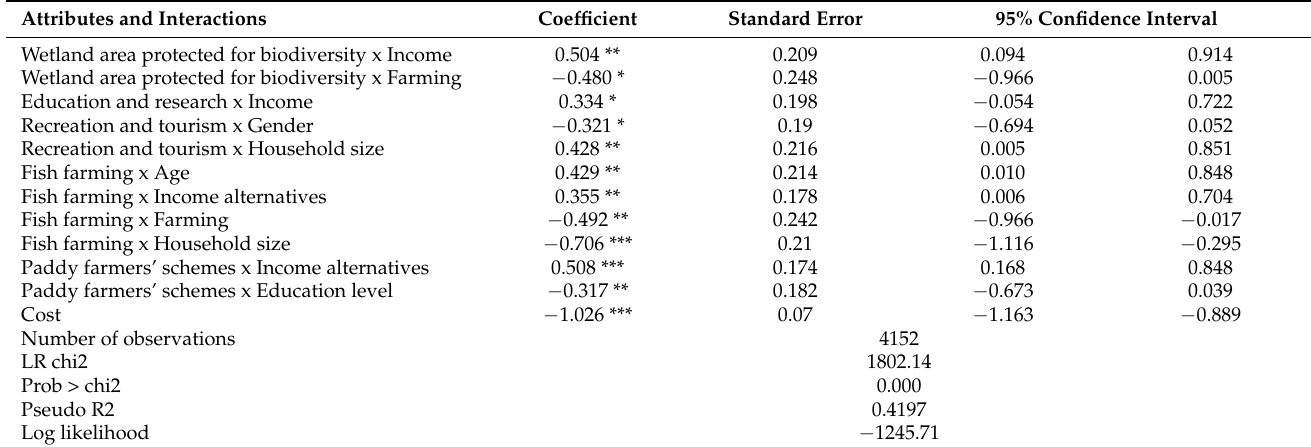
Table 5. Interaction of wetland management attributes with respondents’